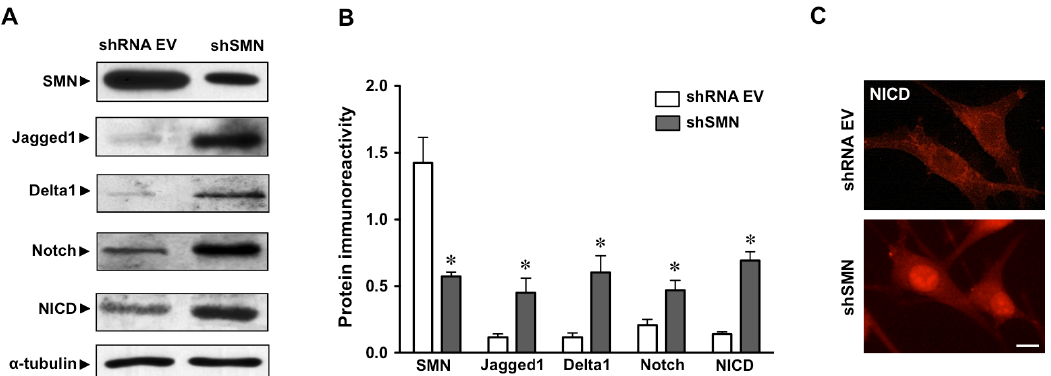
Figure 1. Activation of Notch pathway in U87MG astroglioma cells by Survival Motor Neuron (SMN) depletion. ( A ) Western blots showing SMN, Jagged1, Delta1, Notch and anti-cleaved Notch1 (NICD) immunoreactivities in U87MG cells after transduction with lentiviruses containing the empty vector (shRNA EV) or the shSMN constructs, as indicated. ( B ) Column bars indicate the immunoreactivity of each protein as determined by densitometric analysis (integrated optical density of each protein band vs. that of α -tubulin band), and are the mean ± SEM of three independent experiments. * At least p < 0.01 as compared to shRNA EV. ( C ) Immunocytochemistry showing increased NICD in the nuclei of cells transduced with shSMN construct as compared to that transduced with shRNA EV, as indicated. Scale bar = 10 μ